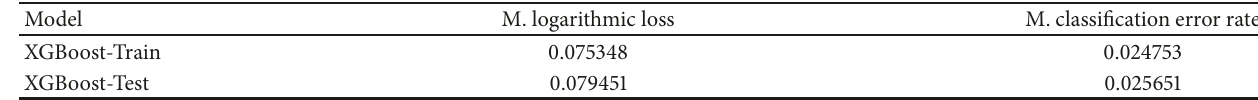
Table 1: Results of evaluation metrics for